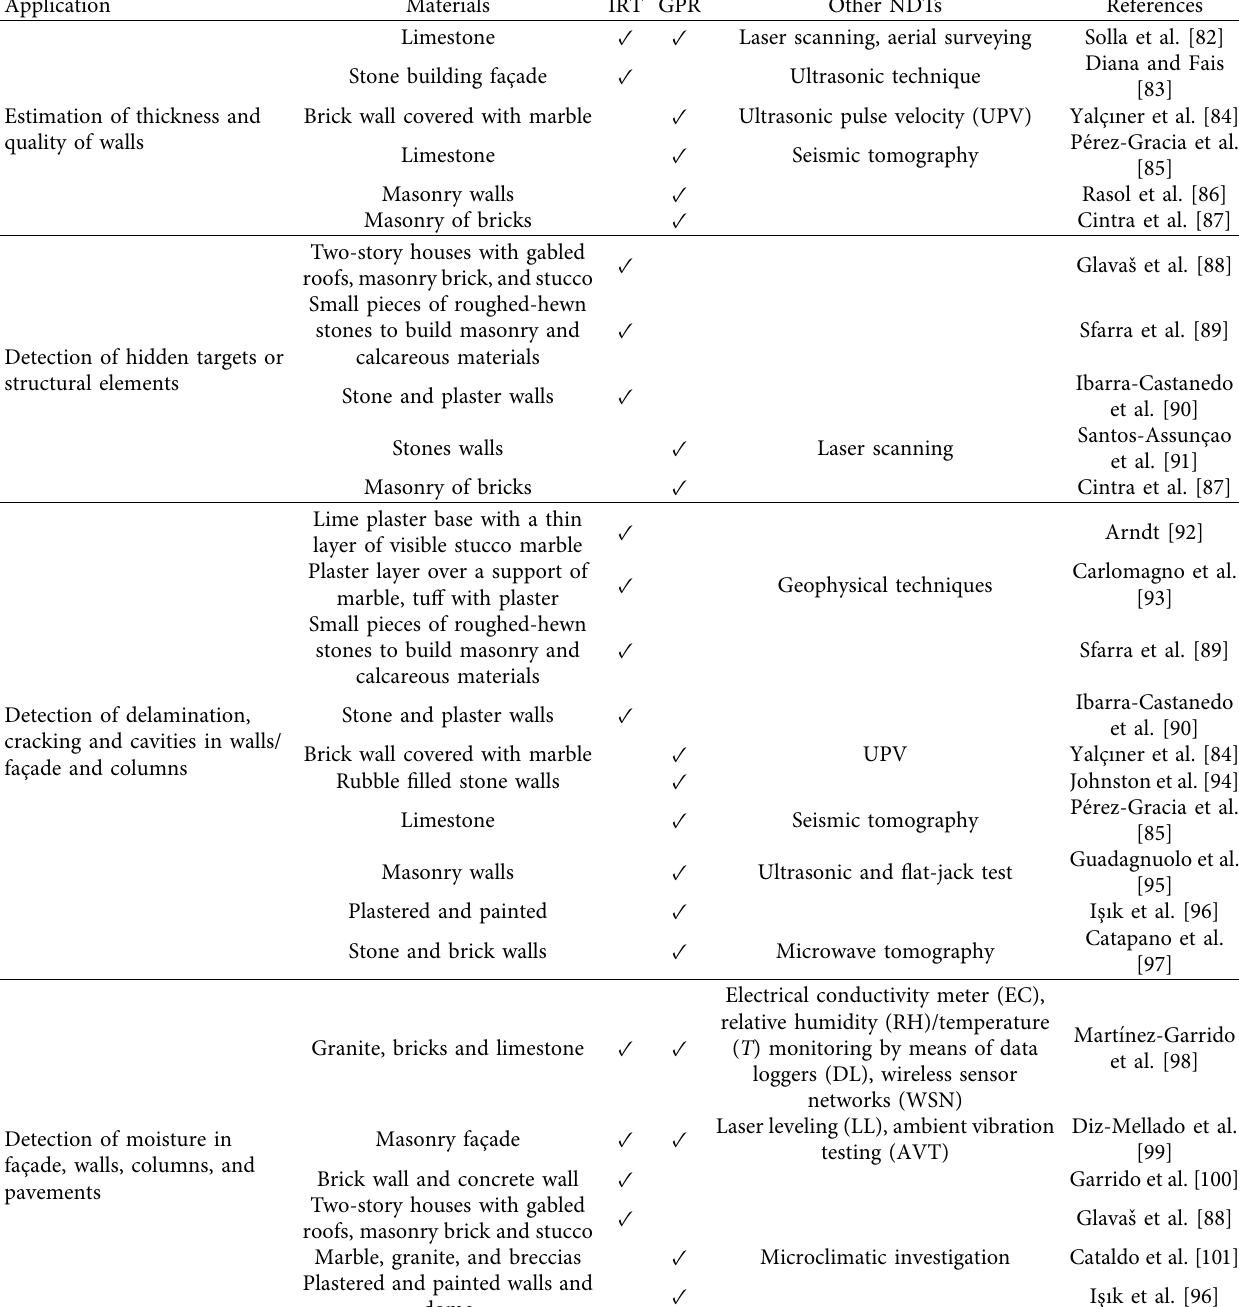
Table 4: Summary table of the state-of-the-art of IRT and GPR techniques applied to cultural heritage